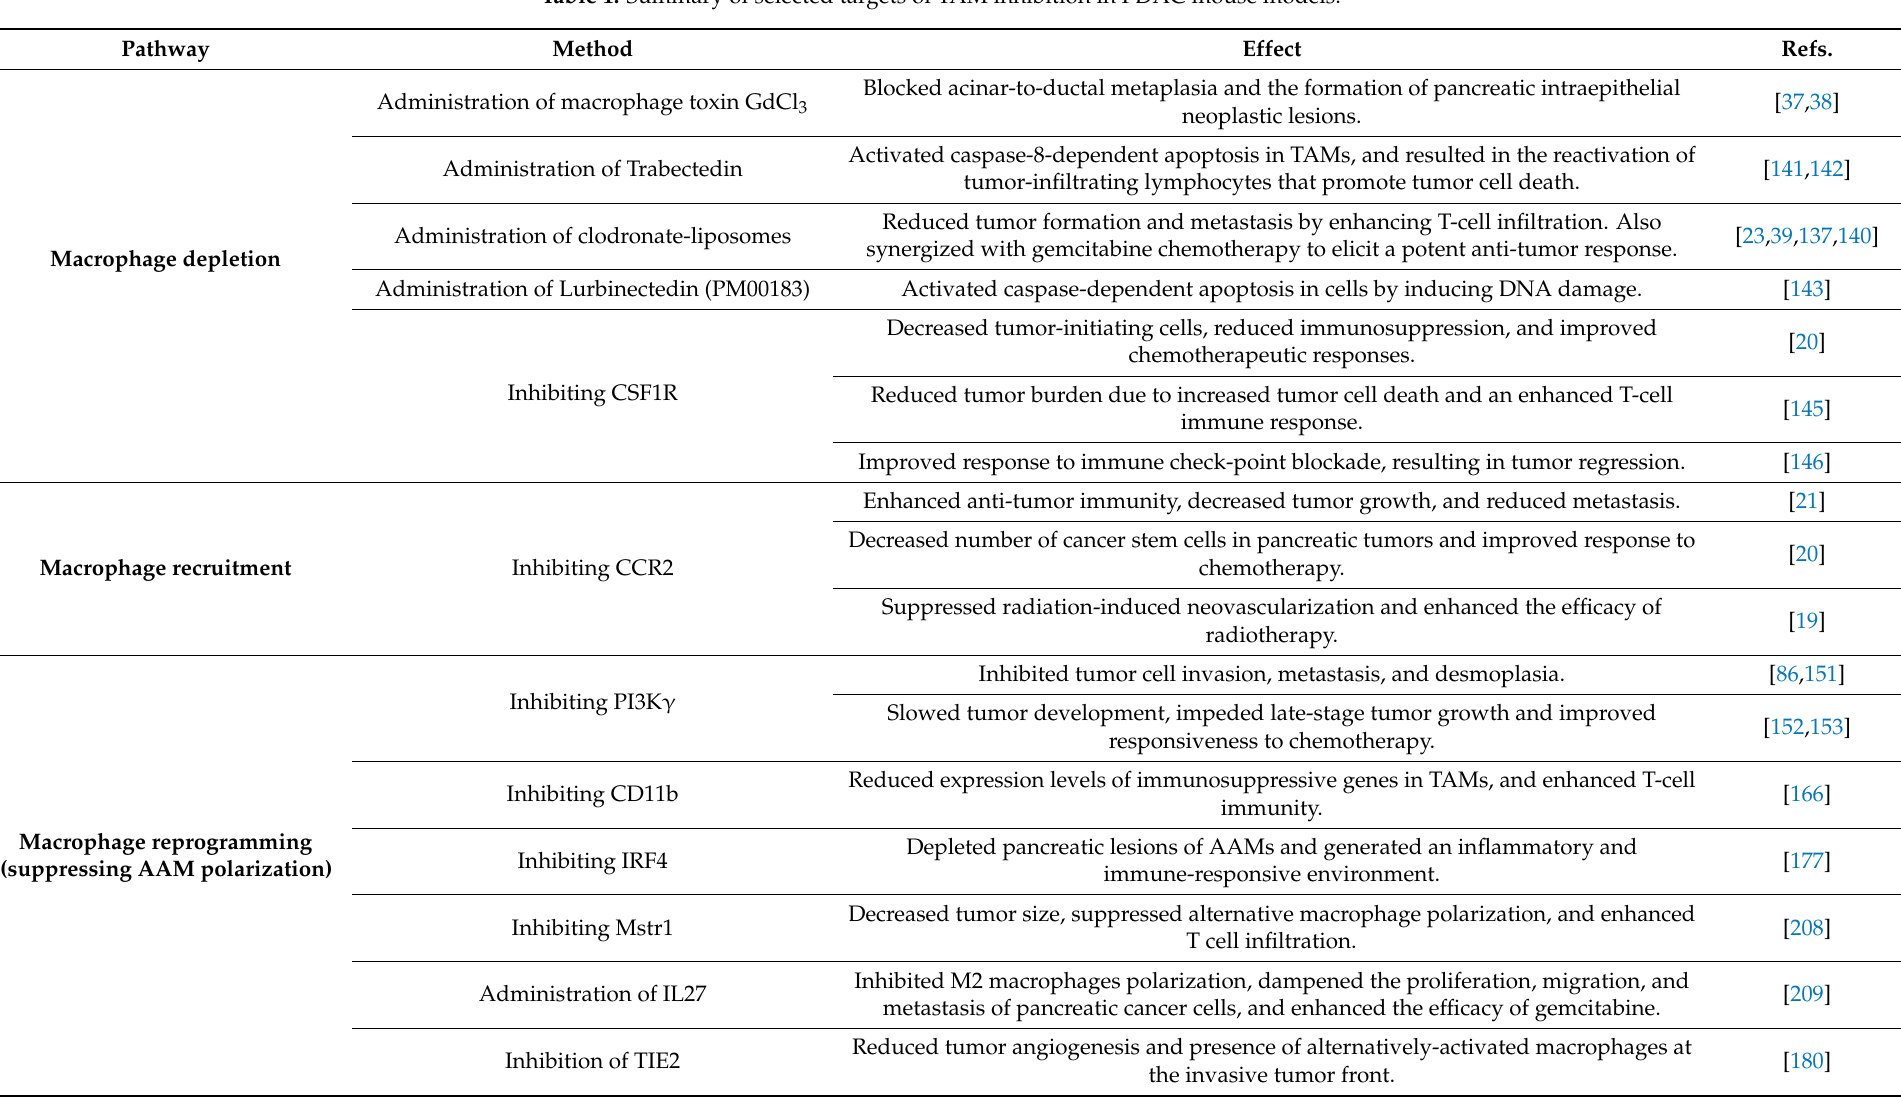
Table 1. Summary of selected targets of TAM inhibition in PDAC mouse